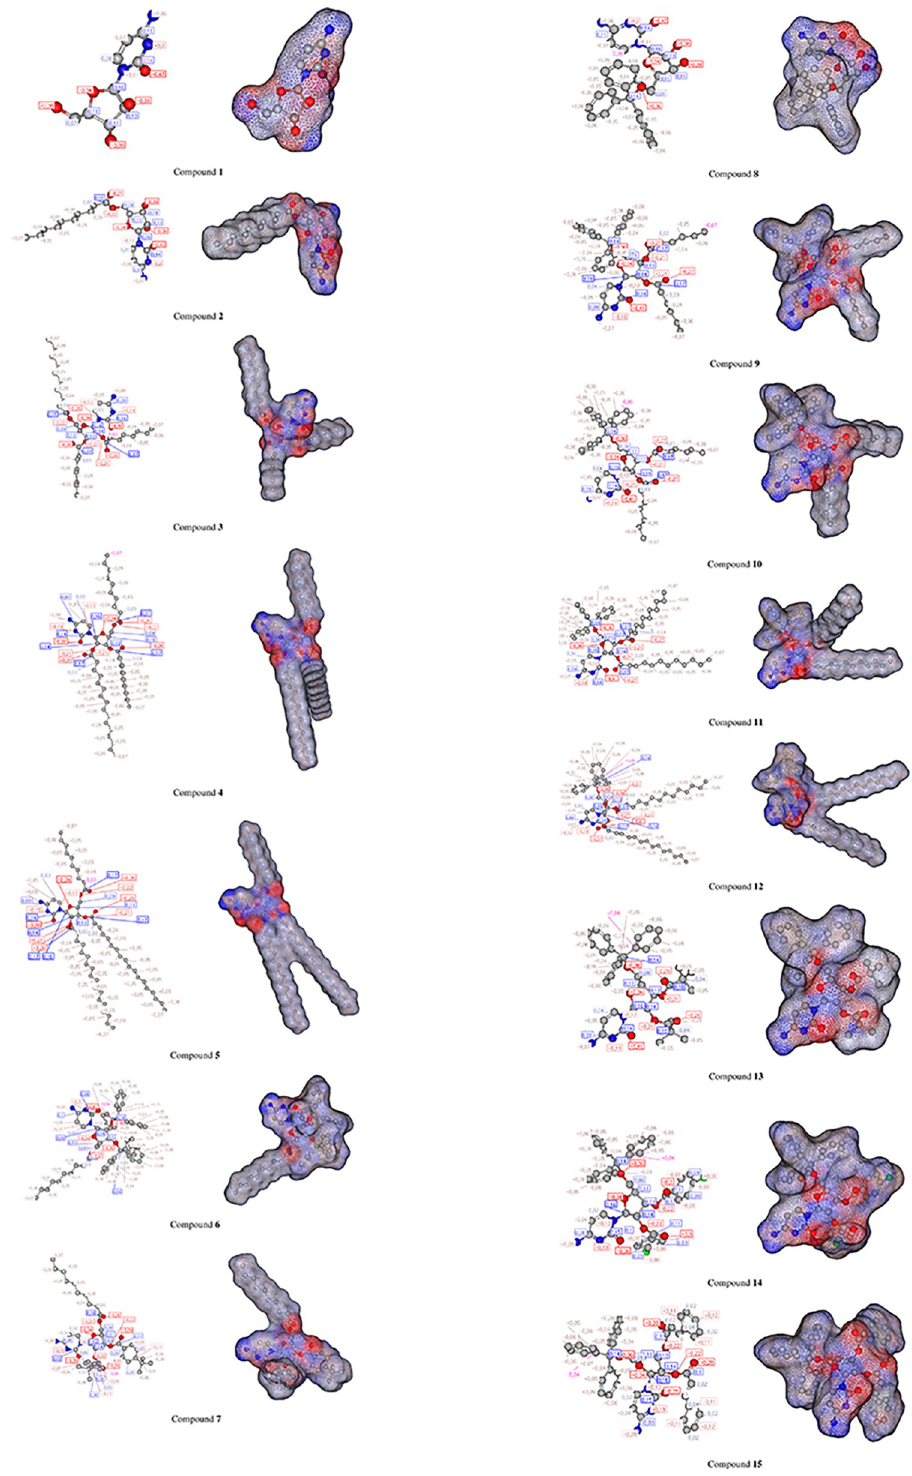
Fig 12. Atomic charge. Calculations of compounds 1–15 .